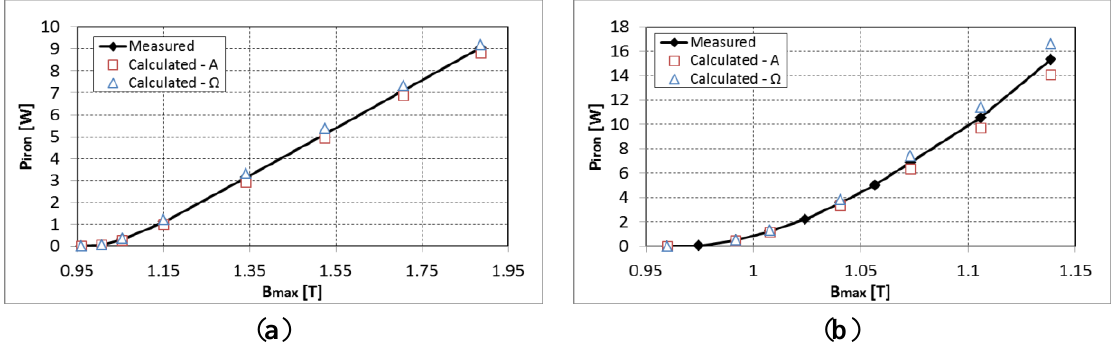
Figure 7. Iron losses with the new k (the offset is 0.96 T).